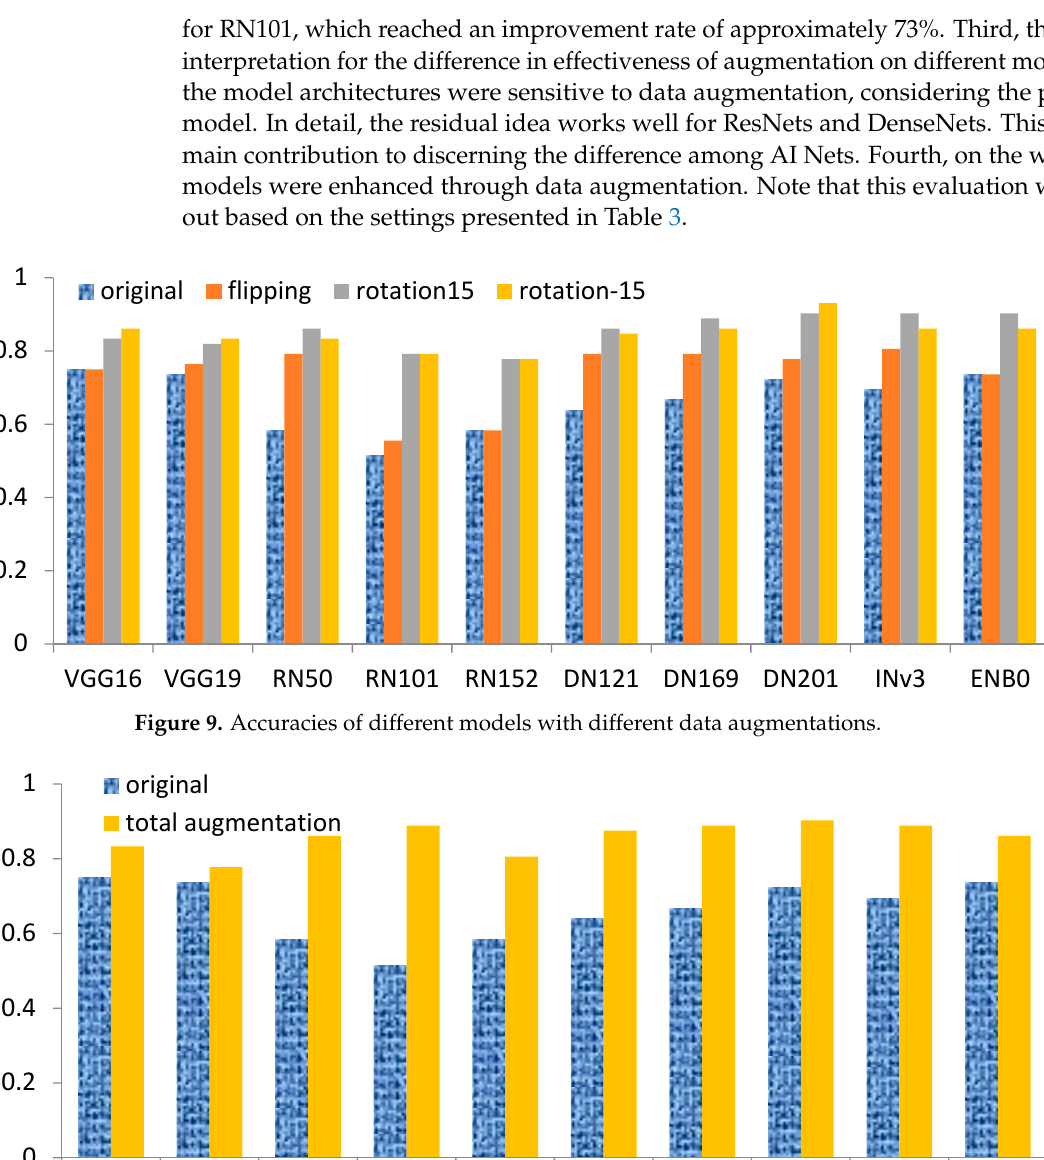
Table 6. Accuracies of compared CNNs for different batch sizes.